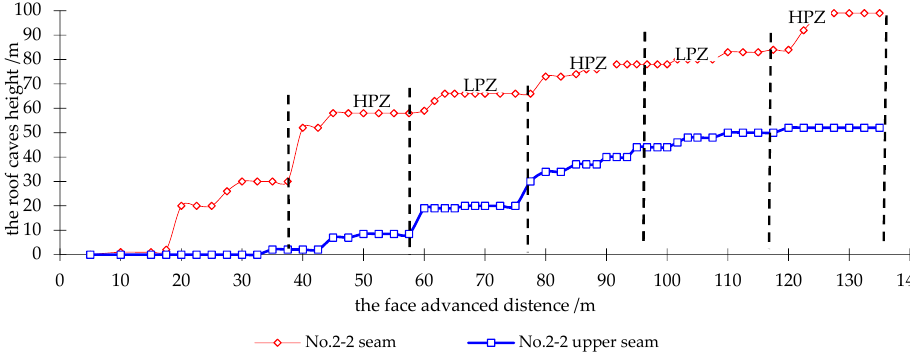
Figure 11. Advanced to 40 ~ 65 m high-pressure zone of the cracks activation.